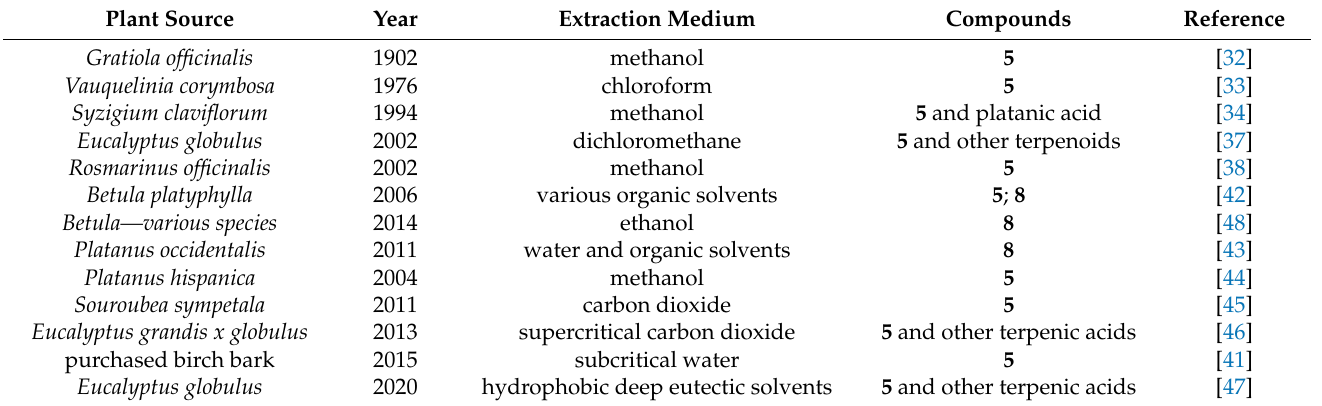
Table 1. Table 1. Main natural sources of lupane